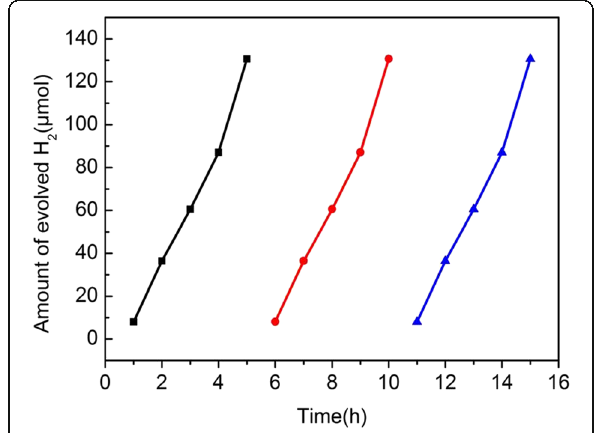
Fig. 8 Three repeat cycle experiments of 3 wt% S,N-GQDs/TiO 2